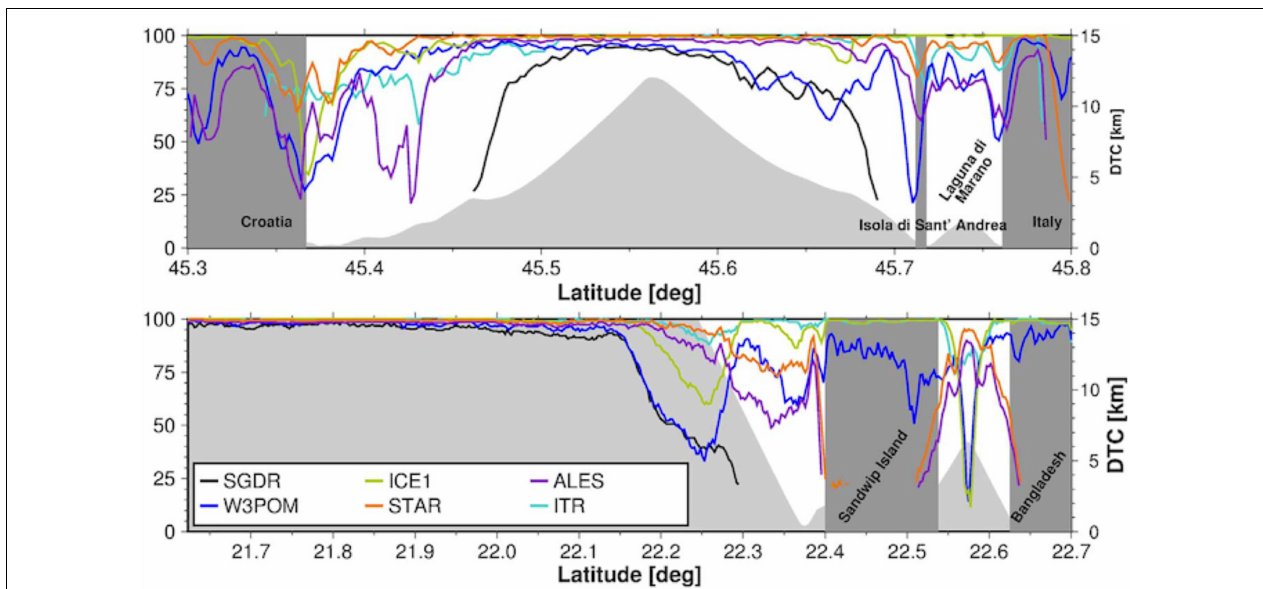
FIGURE 5 | Percentage of the total number of available Jason-2 cycles (227) after applying outlier detection and minimum number of cycles requirement. (Top) Study site at the Gulf of Trieste. (Bottom) Study site at the coast of Bangladesh. The distance to the nearest coastline is provided in light gray. The colored lines correspond to the different retrackers mentioned by their acronym in the insert (adapted from Roscher et al., 2017, with permission).